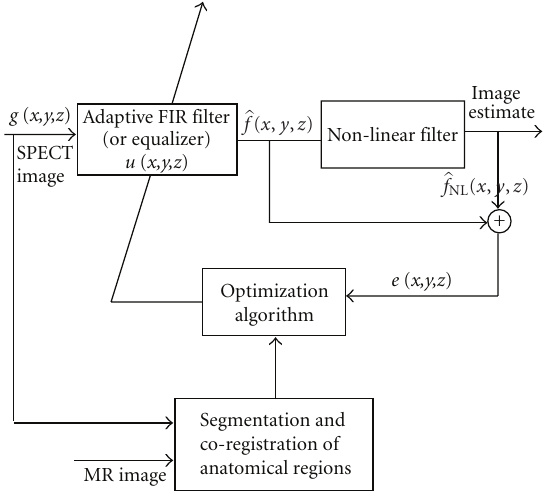
Figure 2: Three-dimensional extension of the NAS-RIF deconvolu- tion algorithm with incorporation of anatomical